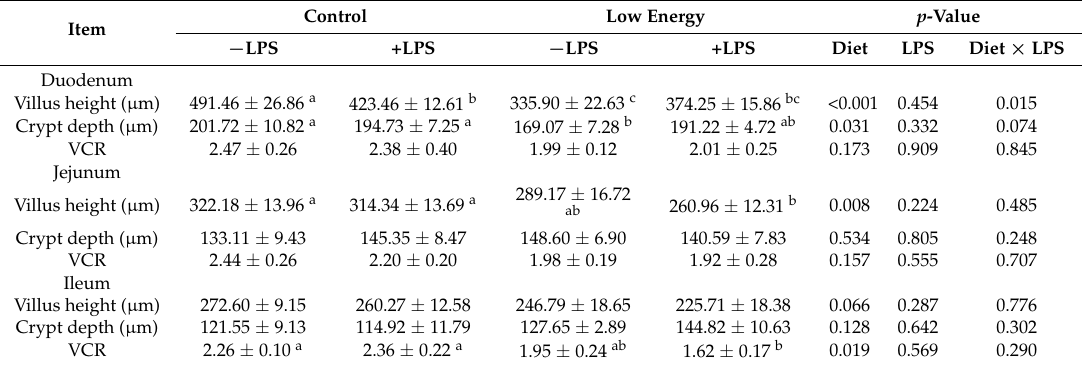
Table 6. Effect of different energy levels during gestation on intestinal morphology of weaning piglets challenged with Escherichia coli lipopolysaccharide.